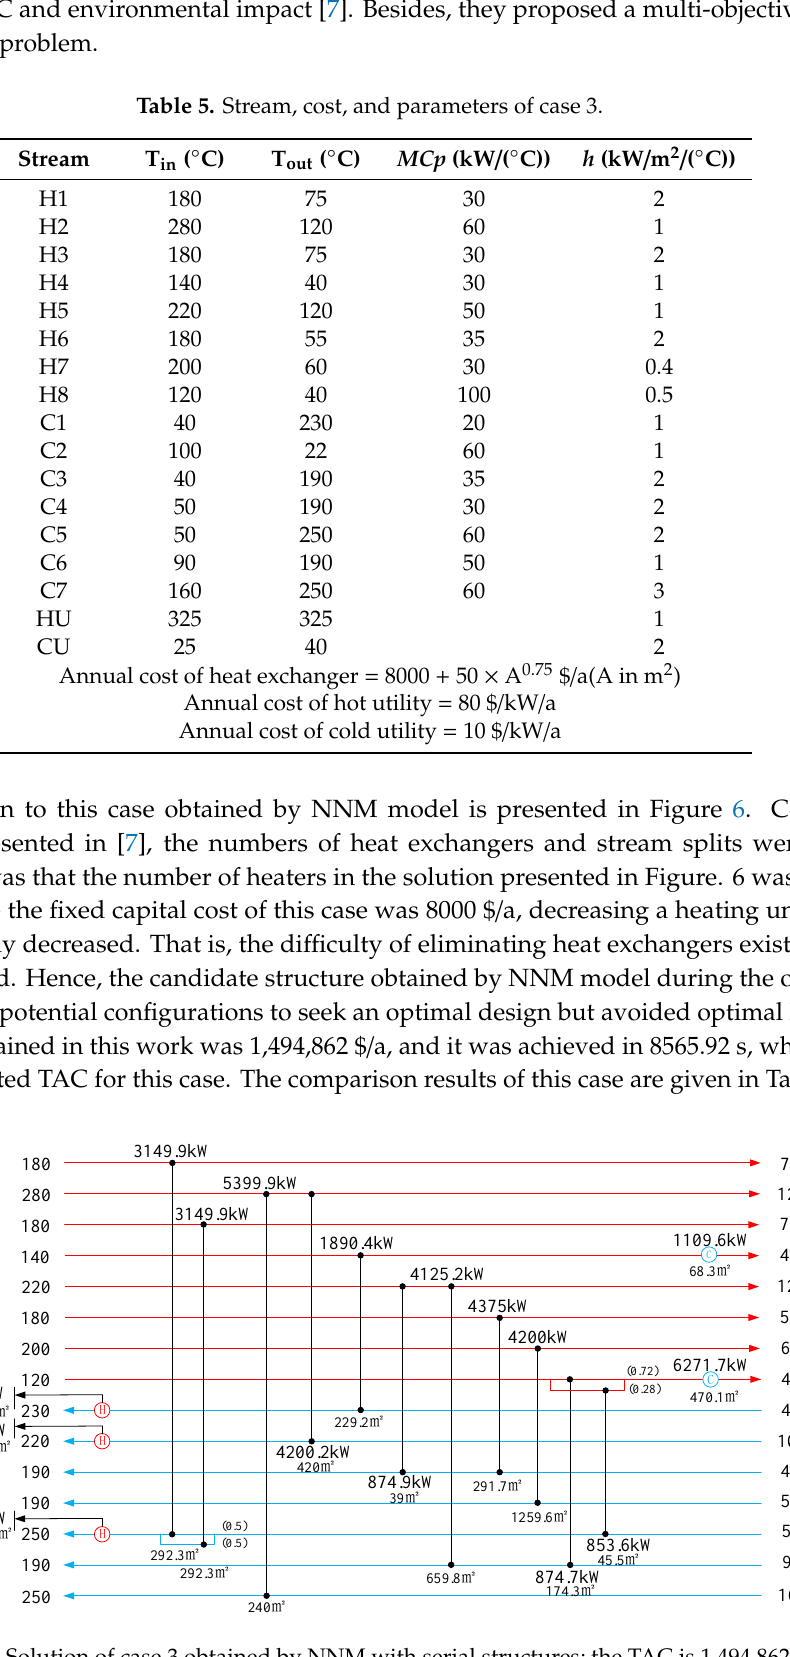
Figure 6. Solution of case 3 obtained by NNM with serial structures; the TAC is 1,494,862 $/a. Table 6. Comparison results of case 3.